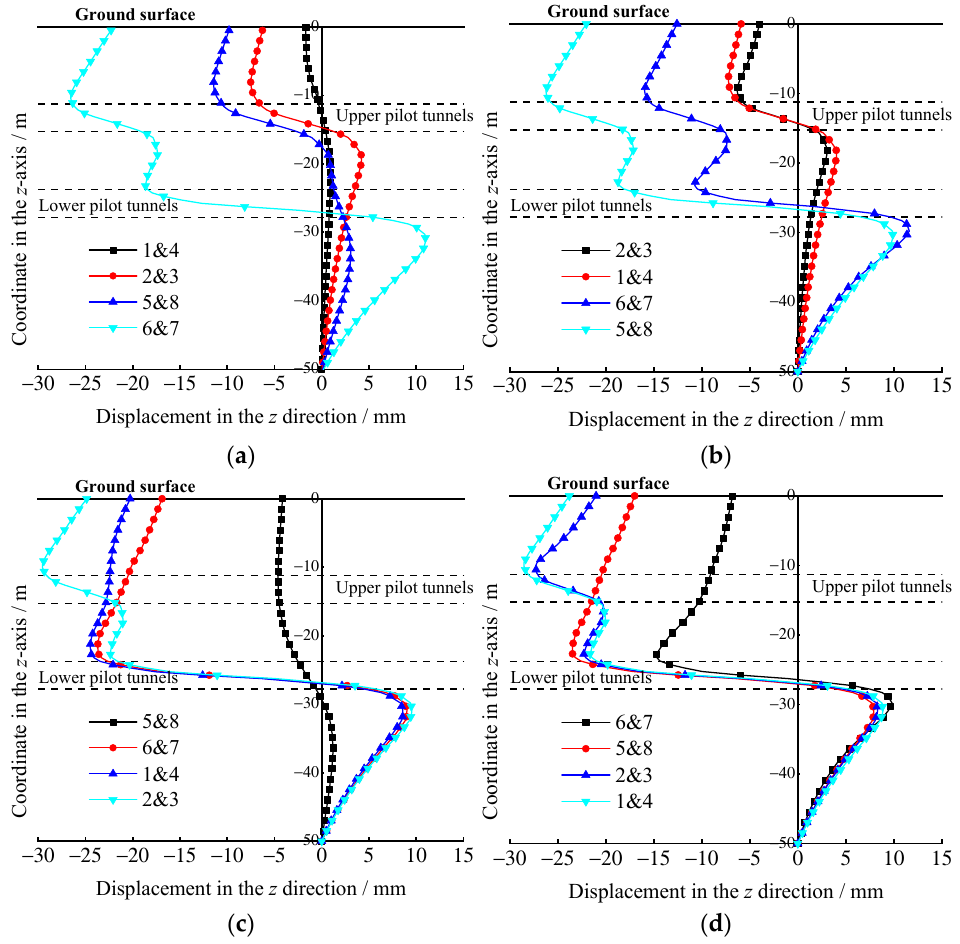
Figure 5. Ground displacement in the four excavation plans: ( a ) 1&4 → 2&3 → 5&8 → 6&7, ( b ) 2&3 → 1&4 → 6&7 → 5&8, ( c ) 5&8 → 6&7 → 1&4 → 2&3 and ( d ) 6&7 → 5&8 → 2&3 → 1&4.